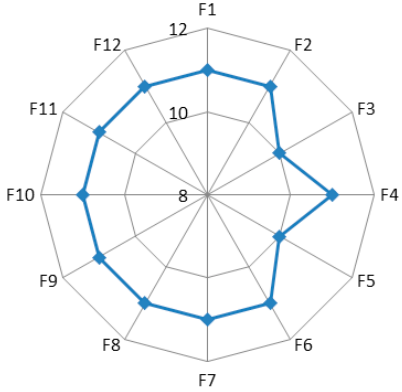
Figure 2. In/out-degree for the one-mode barrier social network. Figure 2. In / out-degree for the one-mode barrier social